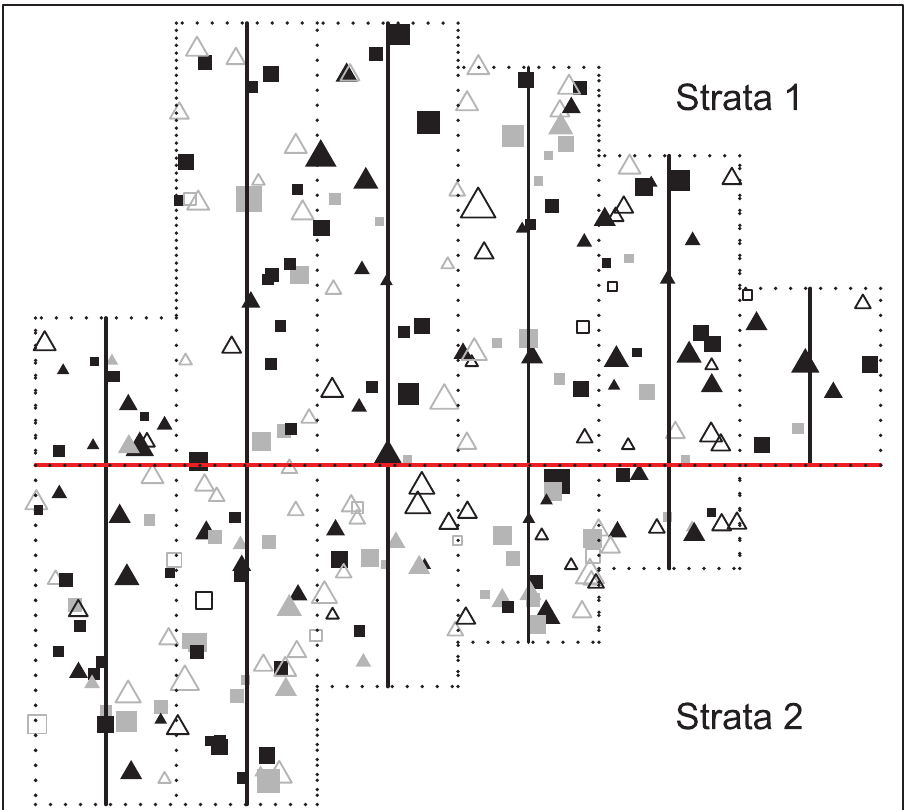
Figure 3. Representation of golf tee population. Each symbol represents a different group of golf tees, with dark symbols representing yellow tees and gray symbols representing green tees. Groups that were observed by at least one observer are indicated by solid symbols, while open symbols indicate groups that were never observed. Squares represent tee groups that were exposed above surrounding grass, while triangles represent unexposed groups. Group sizes are indicated by the proportional size of each symbol, with the smallest symbols representing groups of 1 animal, and the largest symbols representing a group of 8 individuals. Transect lines are represented by solid black lines, with dotted lines giving survey area boundaries and demarcating the areas surveyed by each transect. The red line serves as the strata boundary (points north comprise the northern stratum).